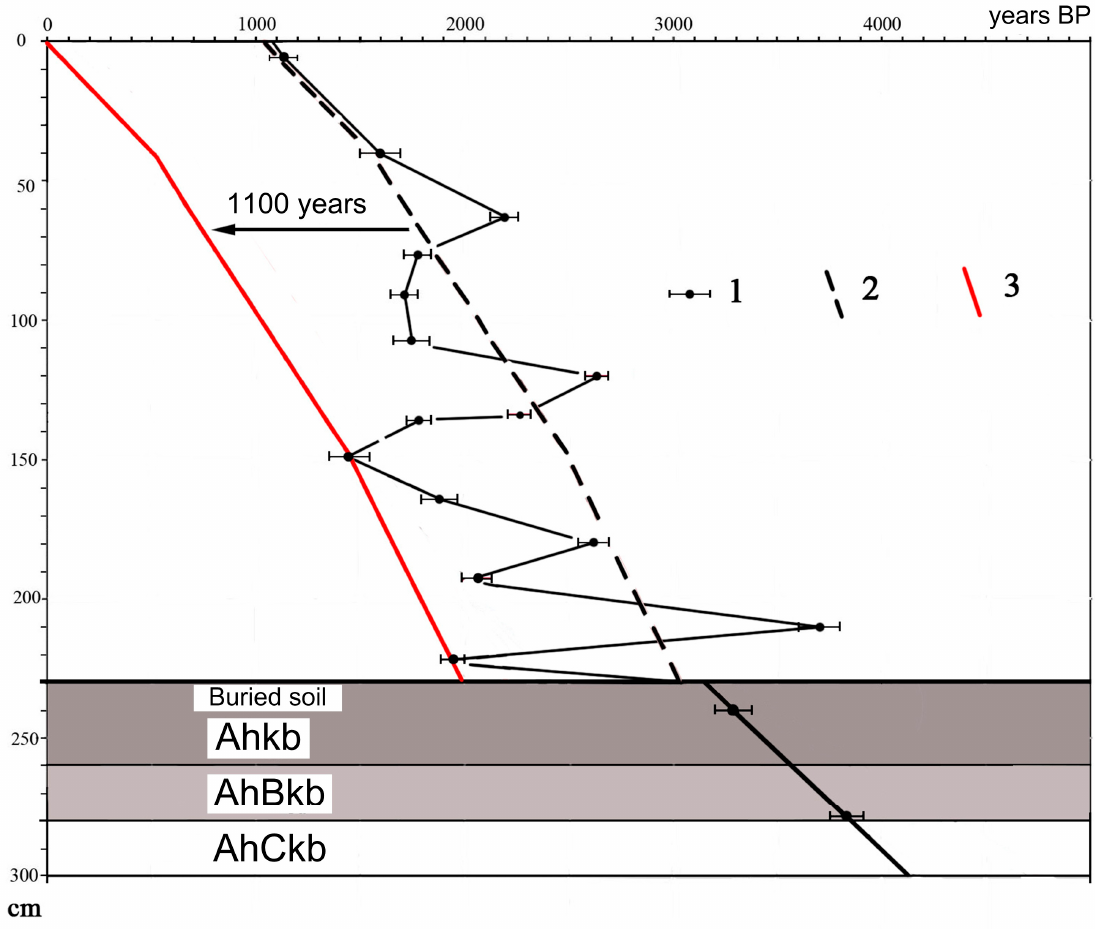
Figure 7. Radiocarbon age (uncalibrated years) of soil C org and the age of layers in the colluvial stratum of “Vishnyaki” gully. 1—radiocarbon age of soils C org with errors of determination; 2—spatial trend of soil C org radiocarbon age in the colluvial stratum; 3—approximate age of deposits in the colluvial stratum (reconstruction).